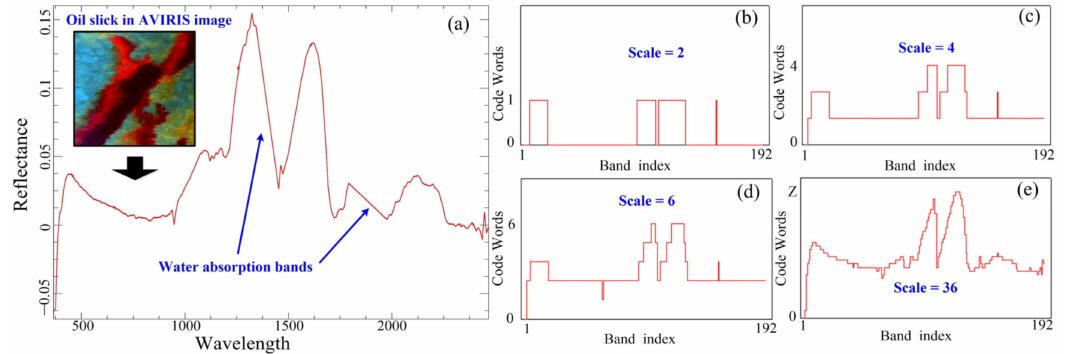
Figure 2. The spectral encoding results of a marine crude oil leakage (( a ), oil slick of Code 5) in an AVIRIS image at different encoding scales ( b – e